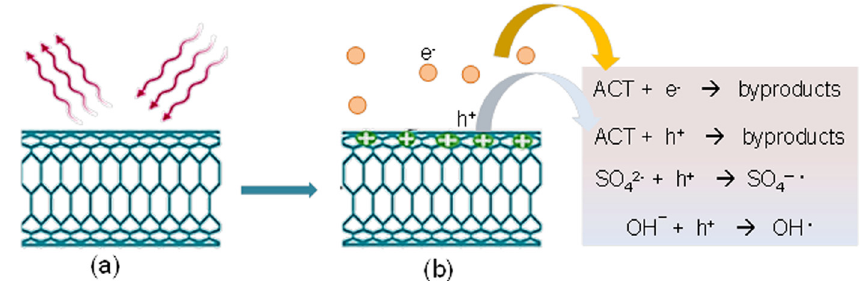
Figure 2: ( a ) The reaction between irradiation waves and the surface catalyst and ( b ) reaction leading to the movement of electrons ( e − ) from valance band to conduction band leaving positives holes ( h + ) , which may react directly with ACT as shown in equation ( 17